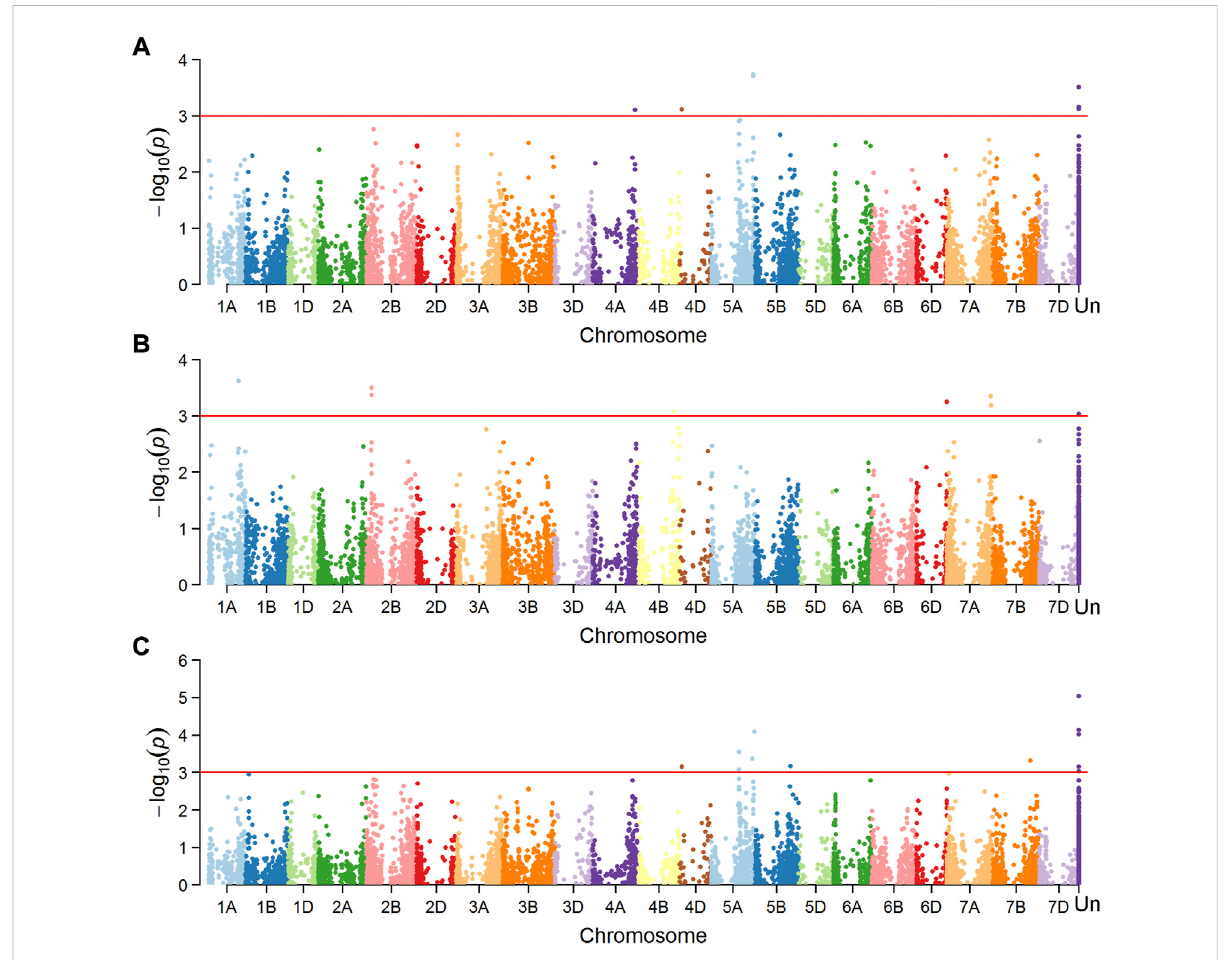
FIGURE 4 Manhattan plots showing SNPs associated with number of diseased spikelets using point inoculation (A) and spawn inoculation (B) , and those for DON content using point inoculation (C) in